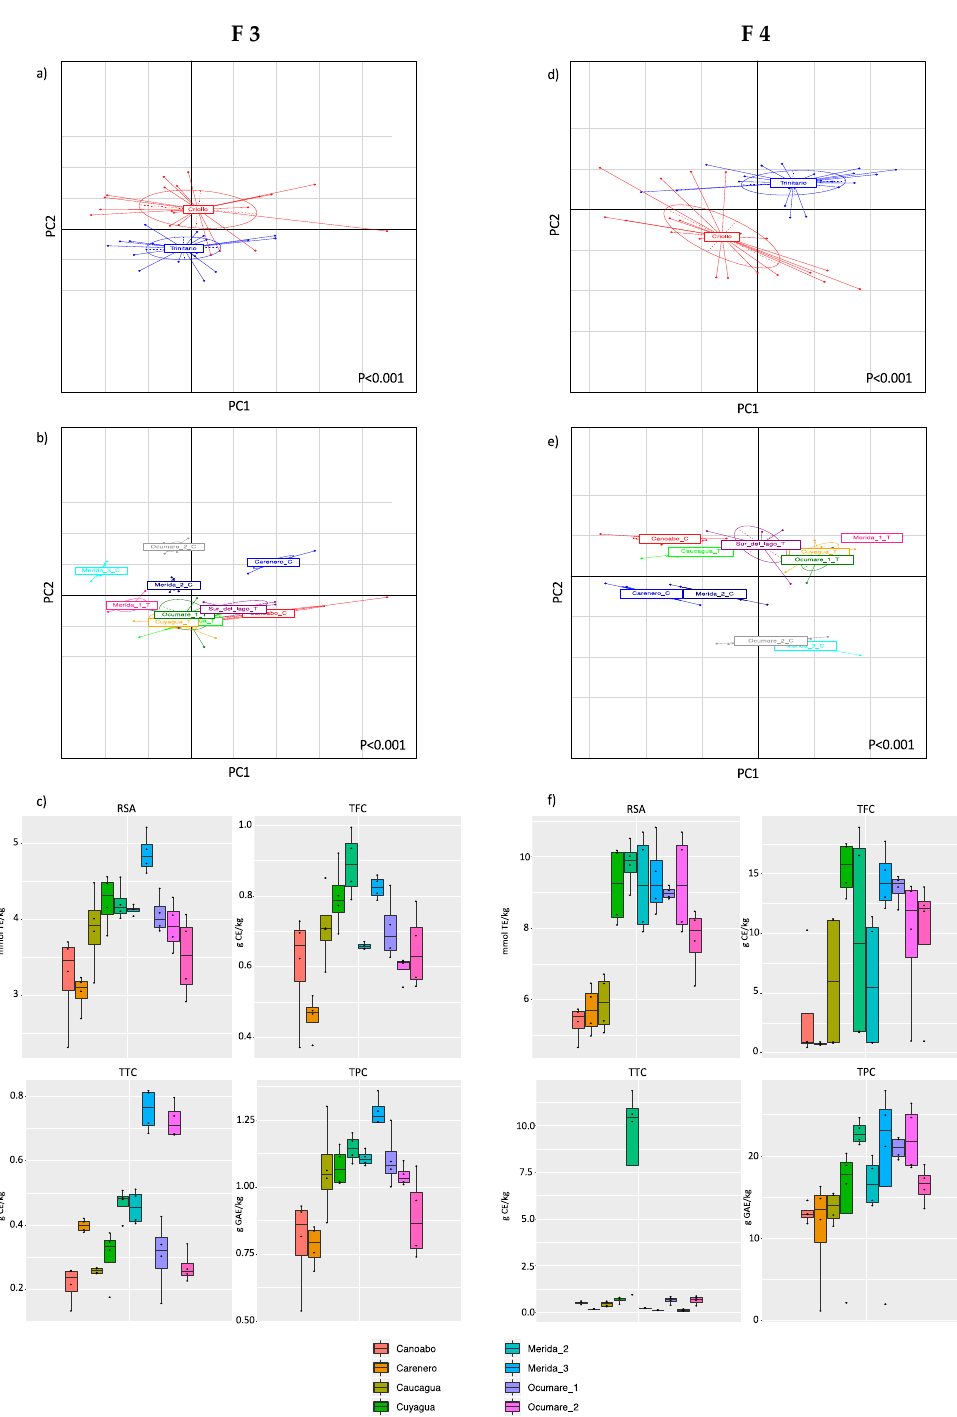
Figure 2. PCAs based on the spectrophotometric assay data (TPC, TFC, TTC, and RSA) of CBS samples from cocoa beans growing in seven geographical areas of Venezuela according to the most representative fractions (F3 and F4). For the F3 PCAs according to ( a ) cultivar and ( b ) geographical area of origin, the variance explained by the first component of PCA was 70.11%, while the second component explained 26.82%. For the F4 PCAs according to ( d ) cultivar and ( e ) geographical area of origin, the variance explained by the first component of PCA was 63.53%, while the second component explained 32.78%. Boxplots show the spectrophotometric assay results that can be used for the classification of CBS according to geographical origin of cocoa beans using F3 ( c ) and F4 ( f